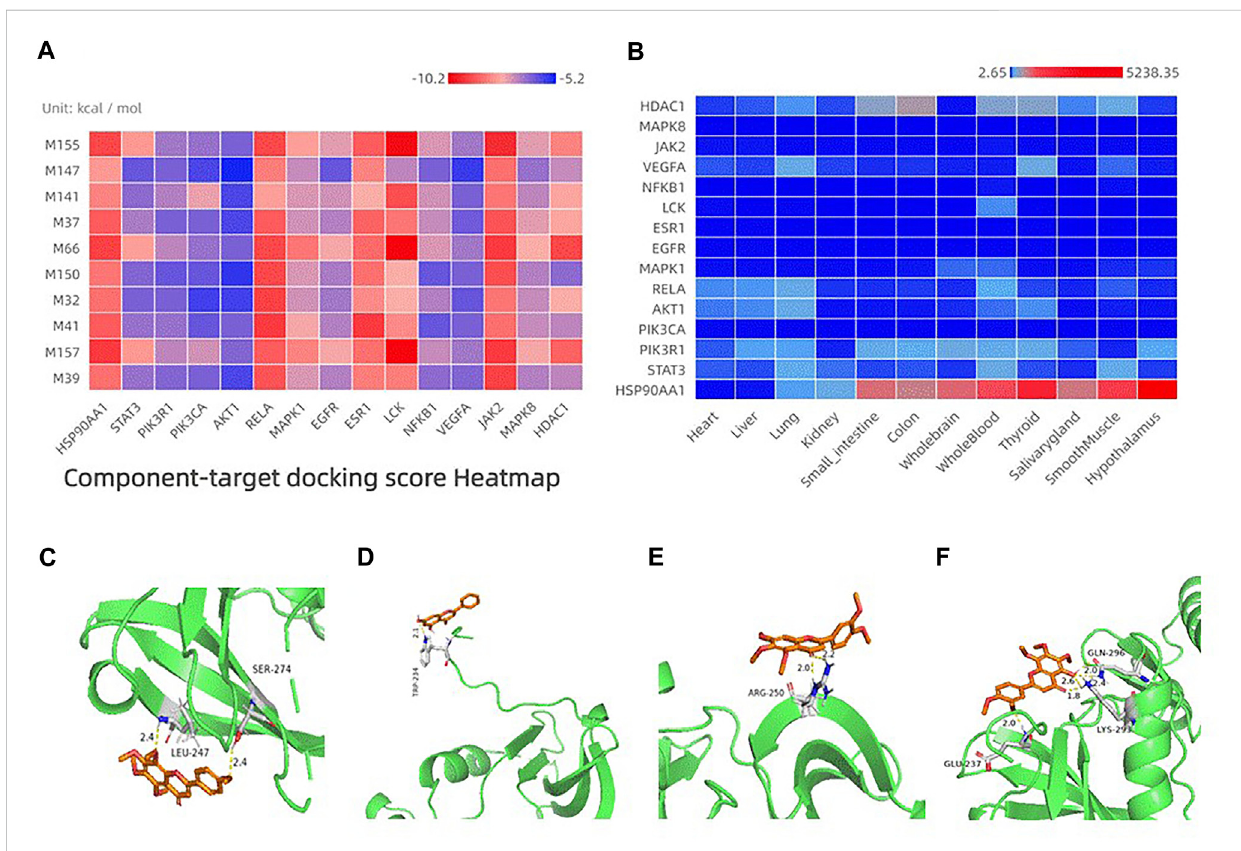
FIGURE 4 (A) Heatmap of the top 15 targets docking with the top 10 components. The x-axis indicates the target name. The y-axis indicates the component name; from top to bottom, acacetin, 3,3 ′ ,4 ′ ,5,6,7,8-Heptamethoxy fl avone, xanthotoxol, tetramethylscutellarein, apigenin, 5,6,7,3 ′ ,4 ′ ,5 ′ - Hexamethoxy fl avone,tangeretin,5-Demethylnobiletin,chrysin,sinensetin. (B) Heatmapoforganexpressionof20targets.Thex-axisindicatestheorgan name. The y-axis indicates the target name; from left to right, heart, liver, lung, kidney, small intestine, colon, whole brain, whole blood, thyroid, salivarygland,smoothmuscle, and hypothalamus. (C – F) Binding studies of selected compound – target interactions. (C) Tangeretin with LCK. (D) Chrysin with LCK. (E) Sinensetin with LCK. (F) 5-demethylmobiletin with LCK. Molecules are represented by a ball-and-stick model. Hydrogen bonds are represented by a dotted line, and numbers indicate hydrogen-bond distances in